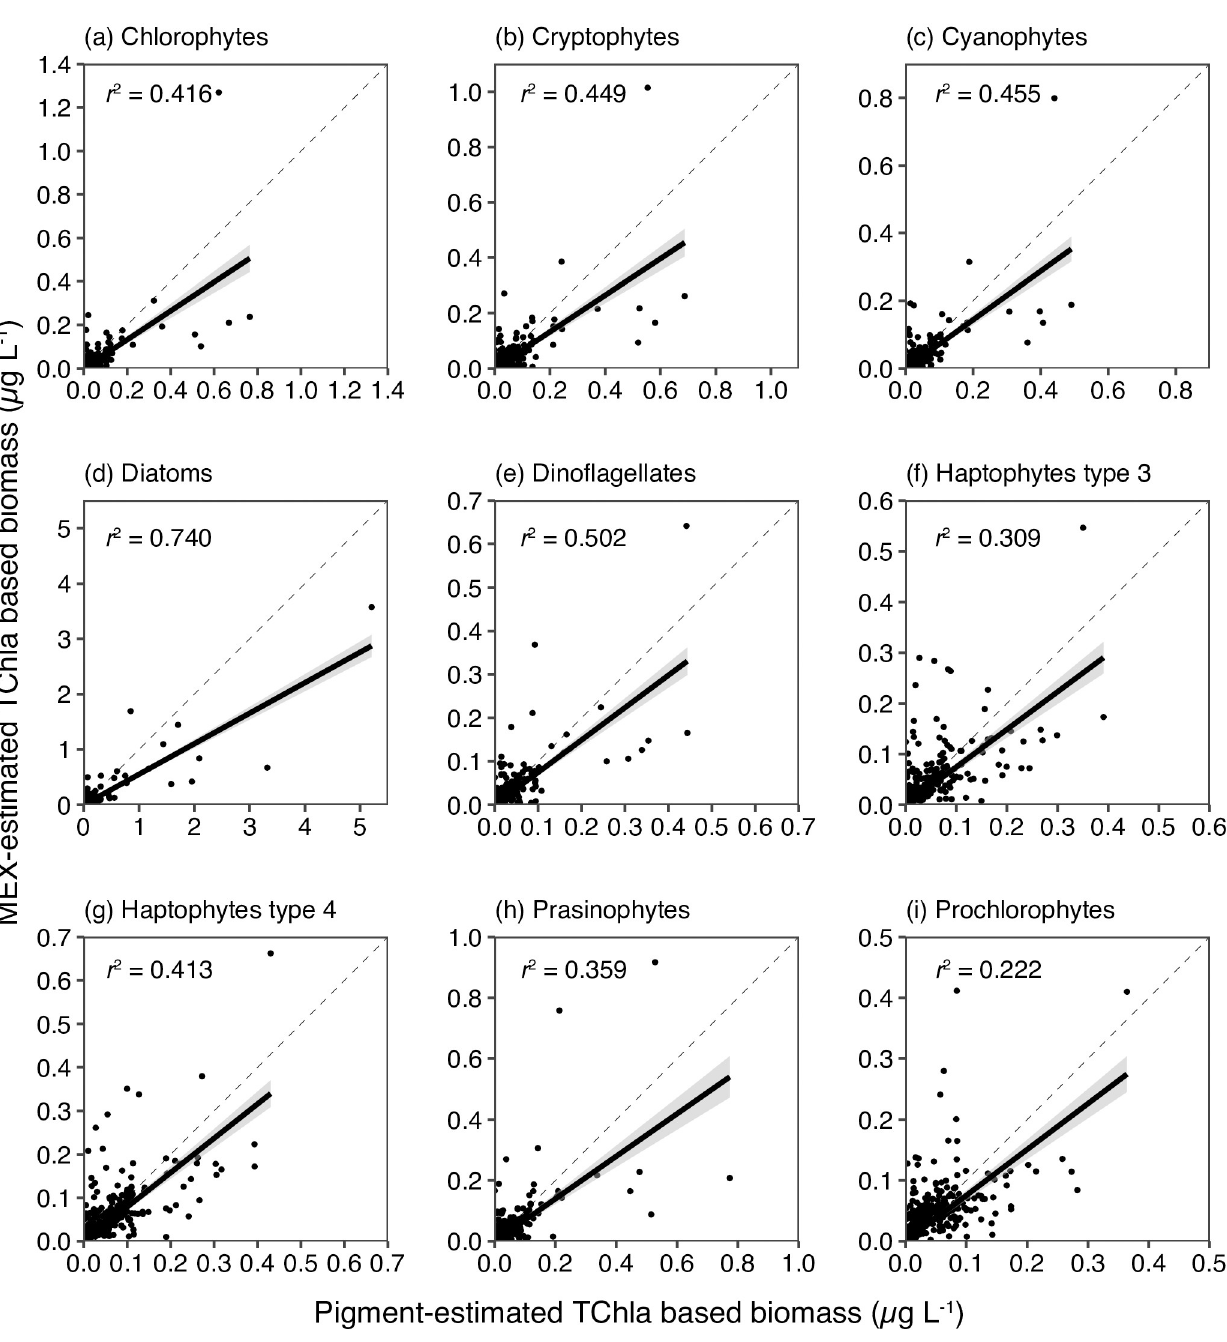
Fig 3. Comparisons of MEX estimated and pigment-based of chlorophyll- a concentration ( μ g L -1 ). Comparisons in nine chemotaxonomy phytoplankton groups (chlorophytes, cryptophytes, cyanophytes, diatoms, dinoflagellates, haptophyte types 3 and 4, prasinophytes, and prochlorophytes). The concentration was computed by multiplying proportions of phytoplankton by TChla or TChla MEX . The thin dashed line denotes the 1:1 line, and the bold line with shadow denotes the linear regression